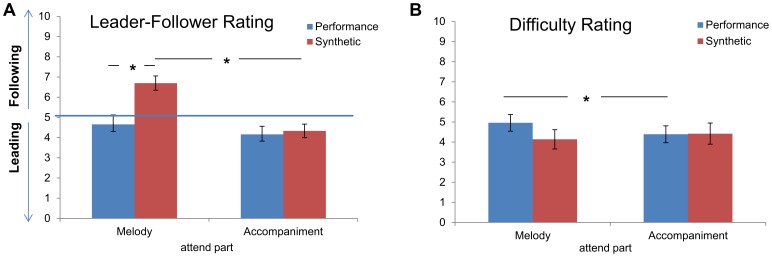
Behavioral ratings.(A) Group mean subjective leader-follower relationship ratings (and standard errors) for Attending to Melody on the left and Attending to Accompaniment on the right. Blue bars represent listening to the performance stimulus, red bars represent the synthetic stimulus. Values >5 (above the horizontal blue line) indicate that the attended part is judged to be subjectively leading, and ratings <5 (below the horizontal blue line) indicate it to be following. (B) Group mean difficulty ratings for all four conditions (and standard error). Asterisks indicate significant differences (α<.025).